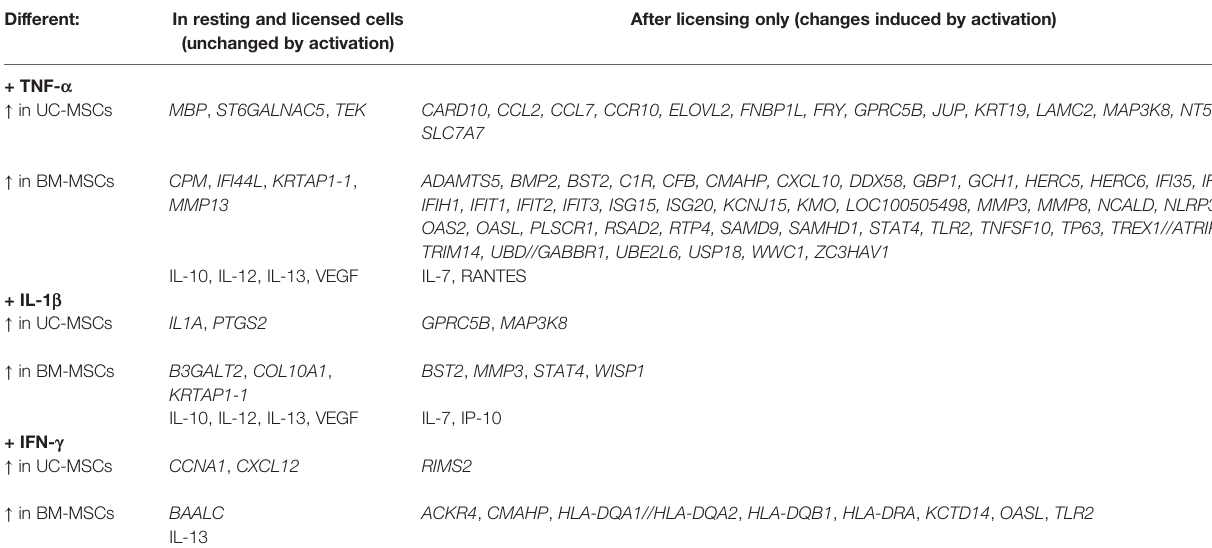
TABLE 1 | Statistically signi fi cant differences between UC-MSCs and BM-MSCs after cytokine activation.